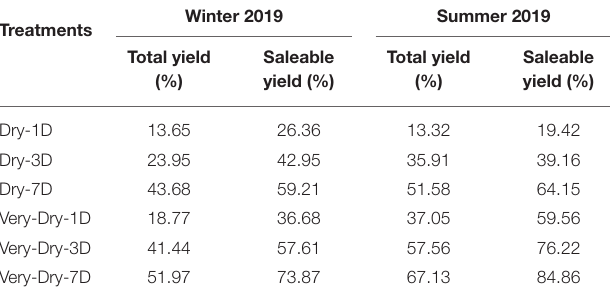
TABLE 1 | Average reduction in the two yield components of stressed plants compared to control plants. Winter 2019 Summer Treatments